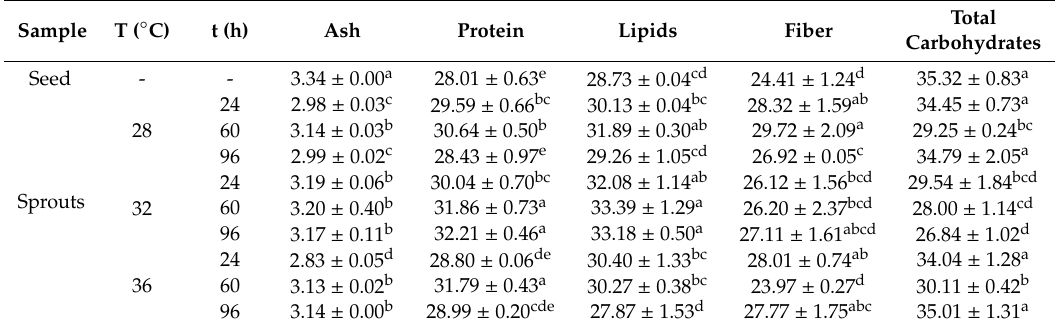
Table 1. Proximate composition (g / 100 g d.m.) of moringa seed and their sprouts obtained at di ff erent germination